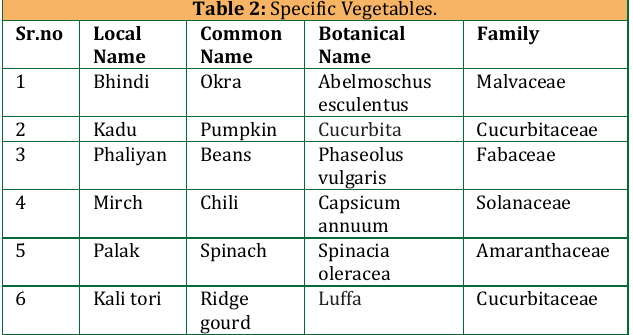
Table 2: Specific Vegetables.